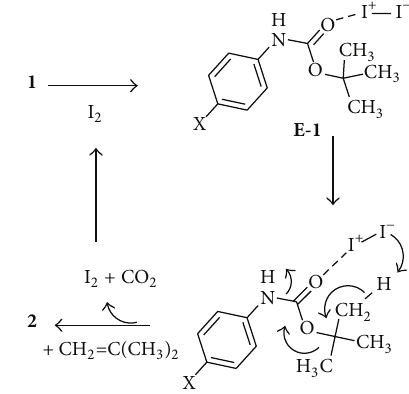
Scheme 2: Proposed mechanism for iodine catalyzed N -Boc depro- tection of 1